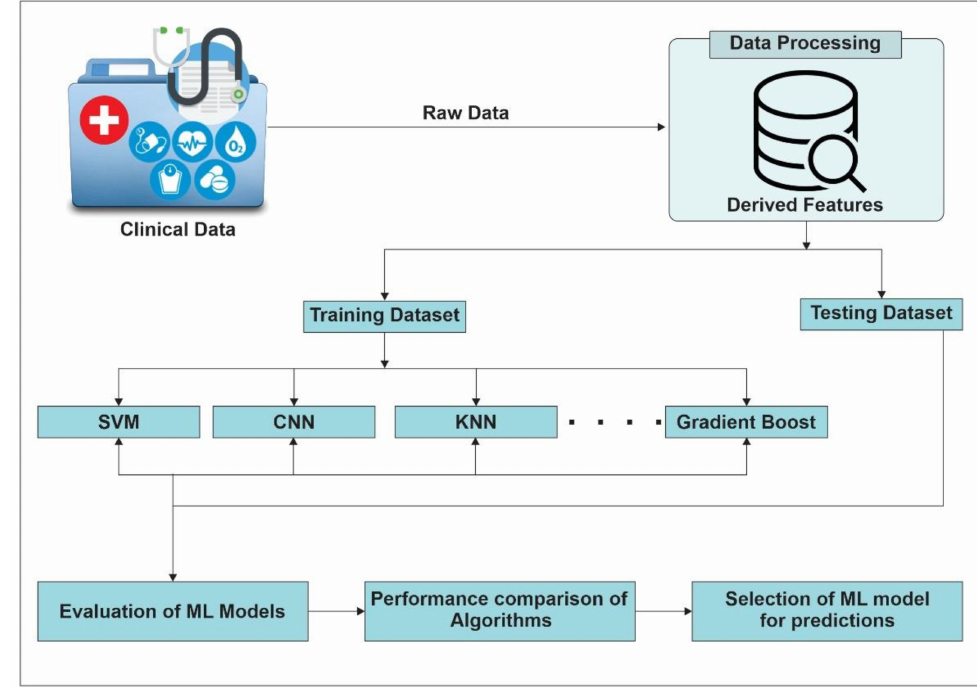
Figure 5. General framework to predict patient’s health status using